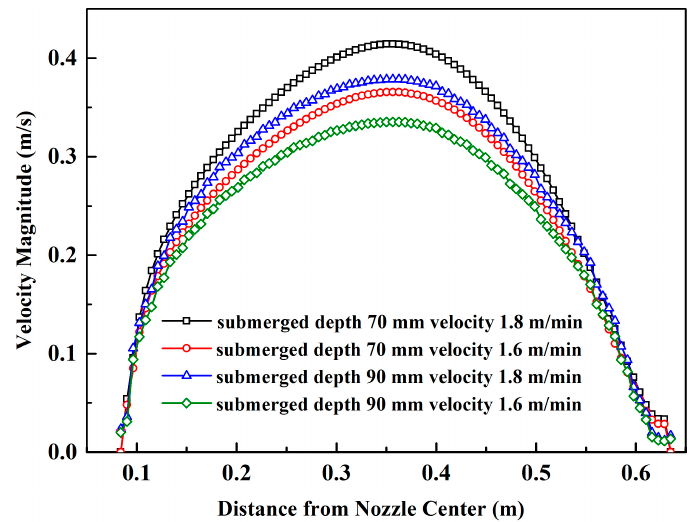
Figure 7. Velocity distribution of free-surface along the central line of the nozzle. Table 1. Maximum surface velocity of different submerged depth and casting speed (m/s).